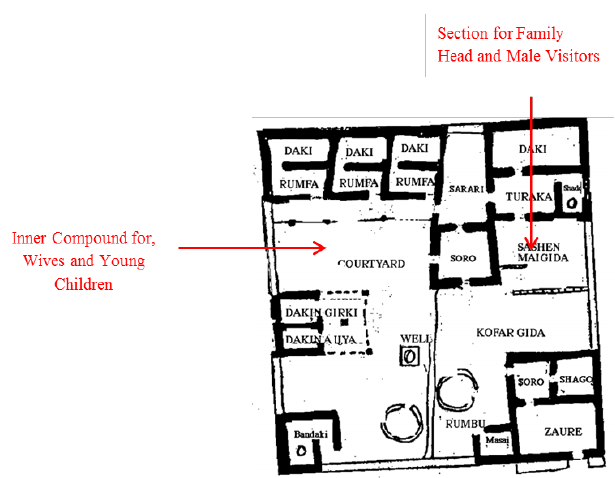
Figure 4ii. Plan of a Hausa compound. Source: Muhammad Oumar, 1997